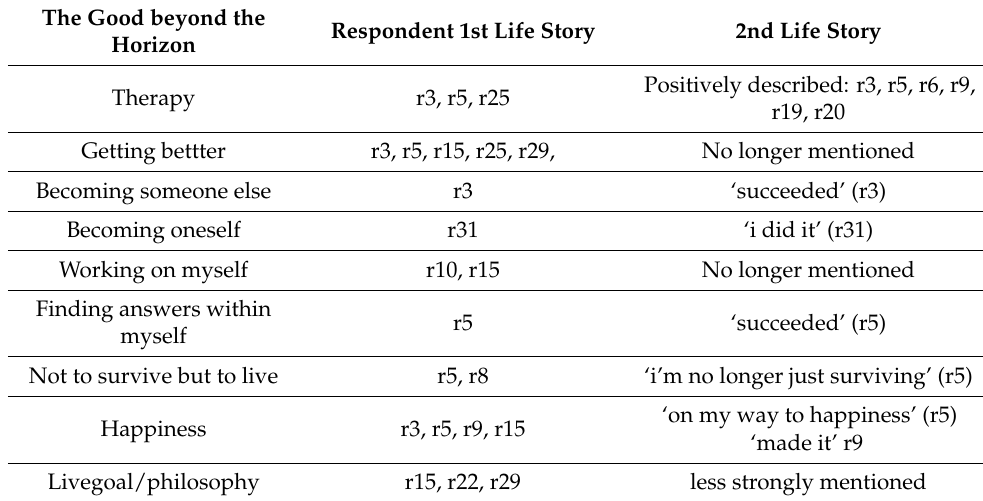
Table 7. The ‘good’ beyond the horizon in the second life